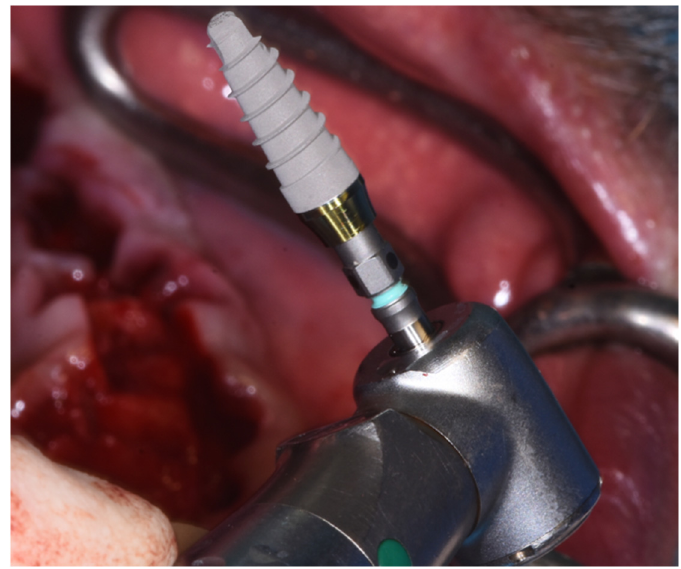
Figure 5. Prama RF implant.